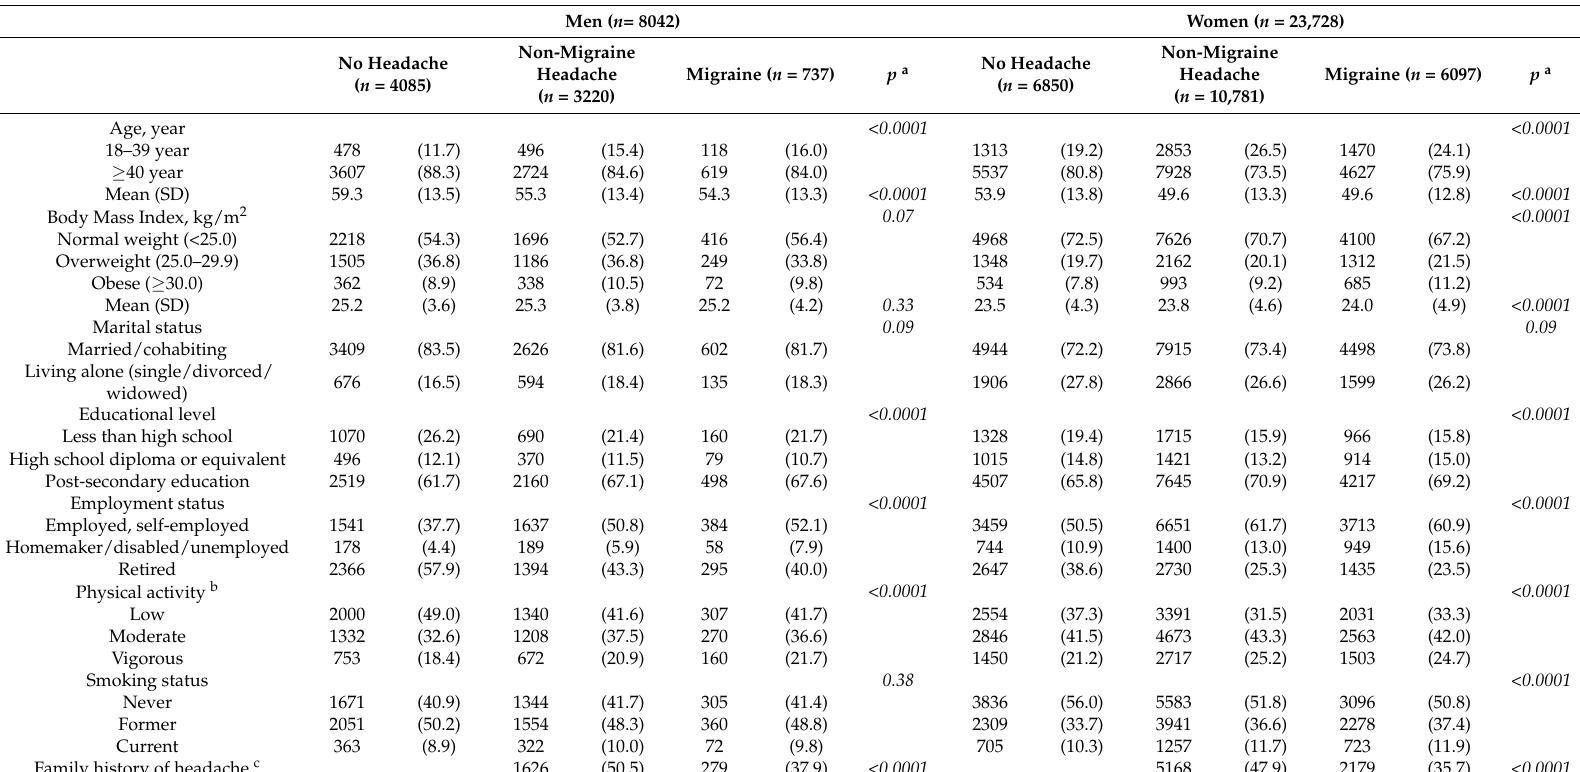
Table 1. Descriptive characteristics of study participants by gender and headache status (NutriNet-Sant é , n =